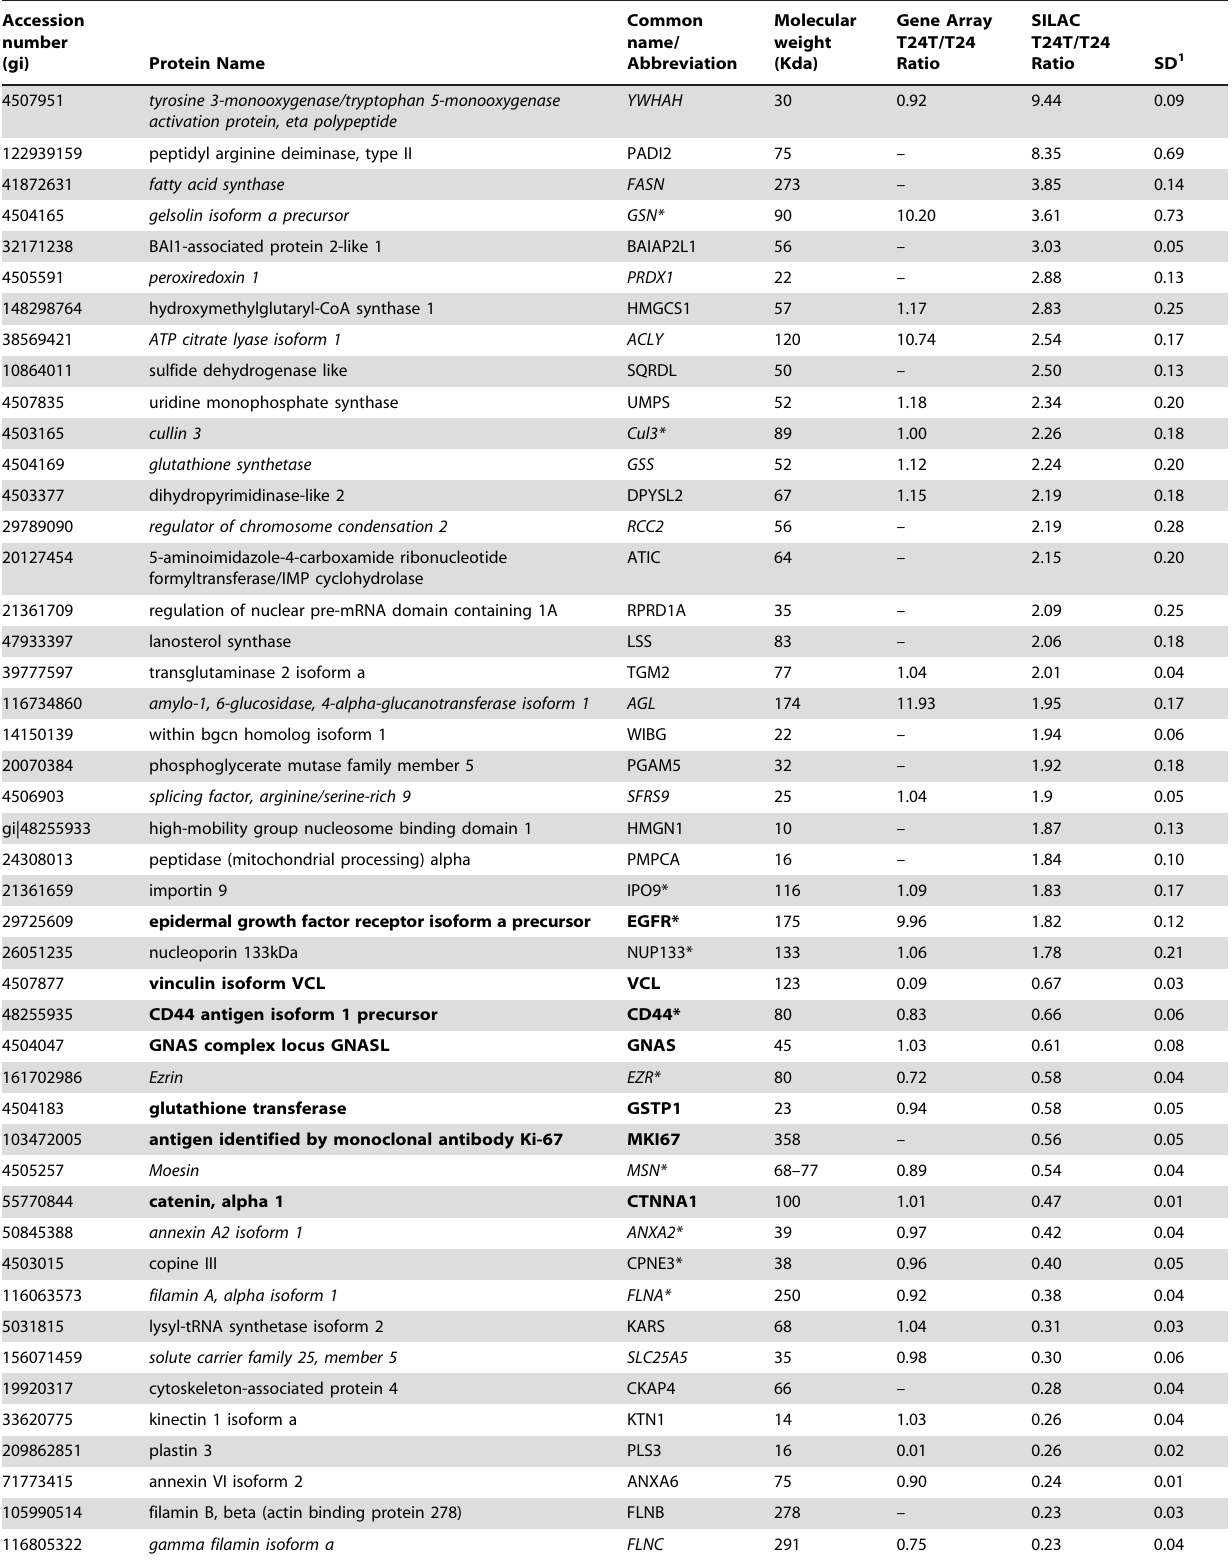
Table 1. Selected proteins with altered abundance in bladder cancer metastatic T24T versus T24